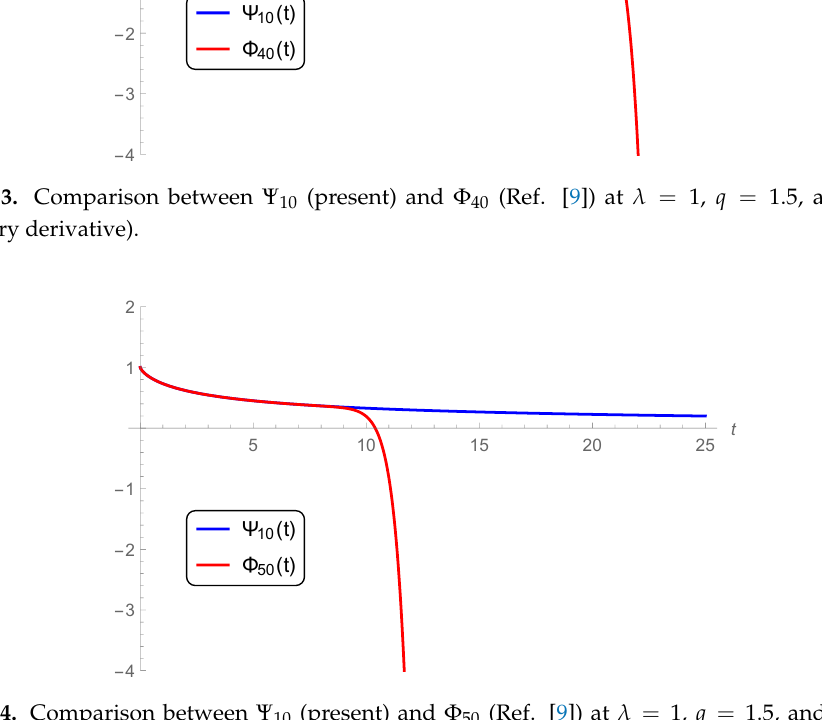
Figure 4. Comparison between Ψ 10 (present) and Φ 50 (Ref. [9]) at λ = 1, q = 1.5, and α = 0.75 (fractional derivative).